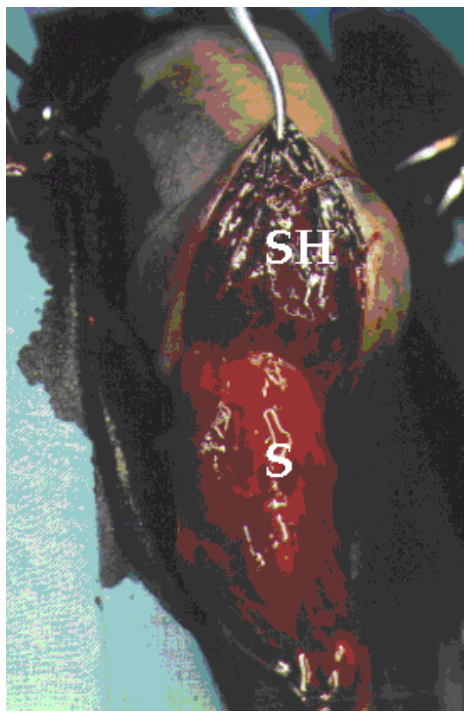
FIGURE 3 . Shaft (S) and subcutaneous hematoma (SH) are evident after penile